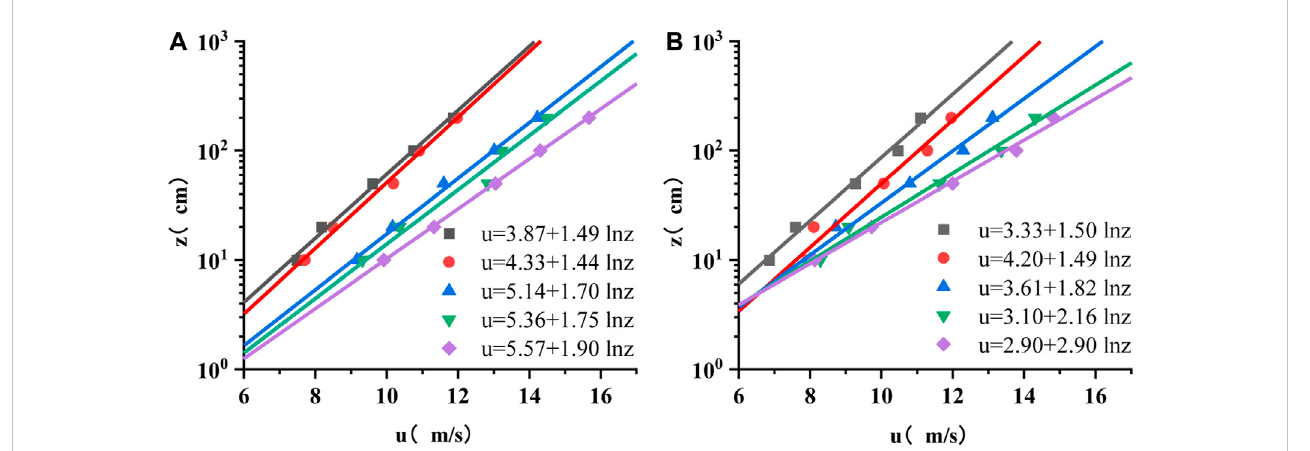
FIGURE 3 Five fi eld observations of wind speed pro fi les on two types of surfaces, R 2 > .95, p < .05.